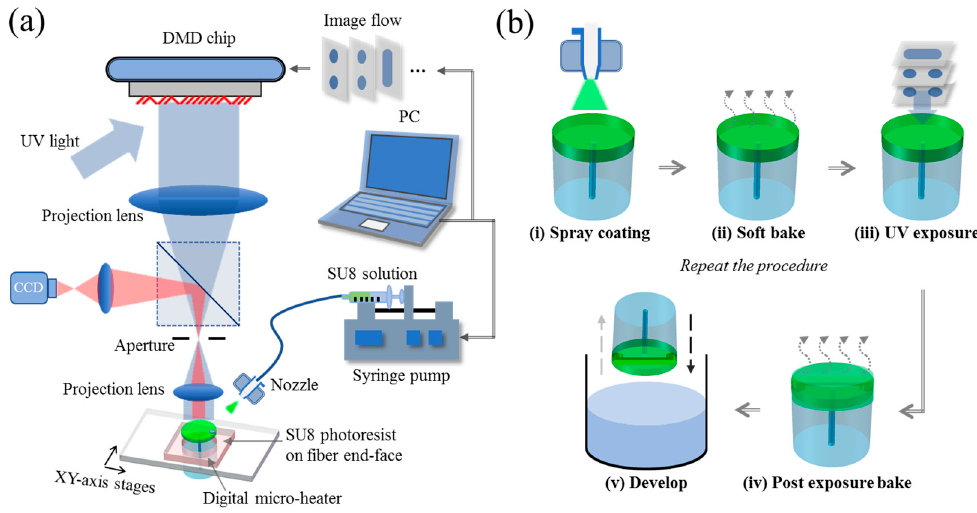
Figure 2. ( a ) Schematic diagram of the optical 3D µ -Printing technology. ( b ) Flow chart for printing the optical fiber-tip sensors.